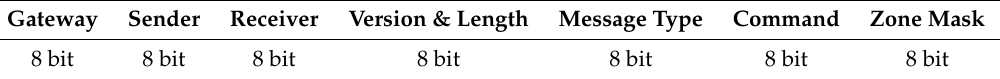
Table 8. Message head of RF2.4G message.